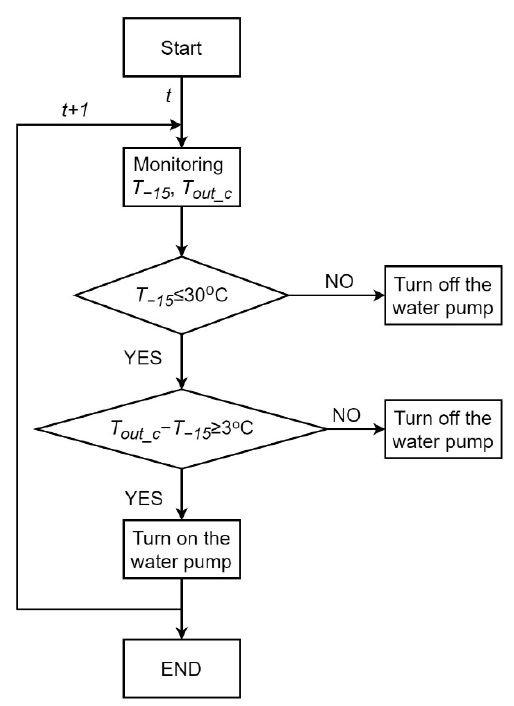
Figure 6. Schematic diagram of the water pump control strategy.